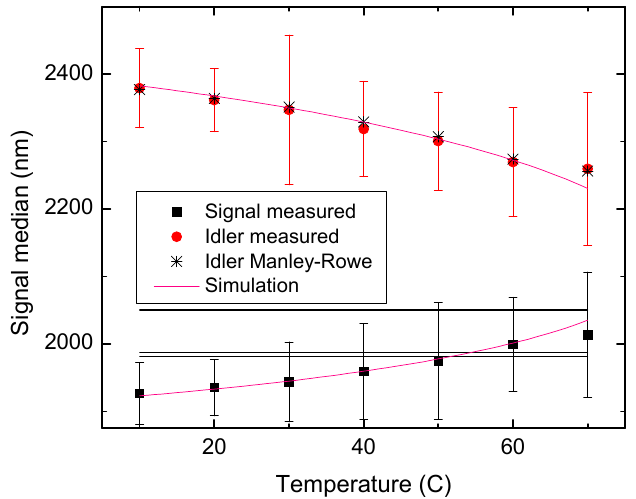
Figure 10. Signal and idler wavelengths as a function of temperature in the OPO comprising PPKTP with 38.75 µm periodicity. Measured peak wavelength (solid points), idler wavelength determined from Manley–Rowe relations (crosses), and calculation (red line). Horizontal lines determine the target spectral ranges. Error bars demarcate the FWHM of the measured spectra.